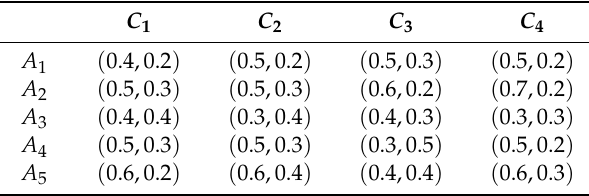
Table 11. The original fuzzy decision matrix A 3 given by D